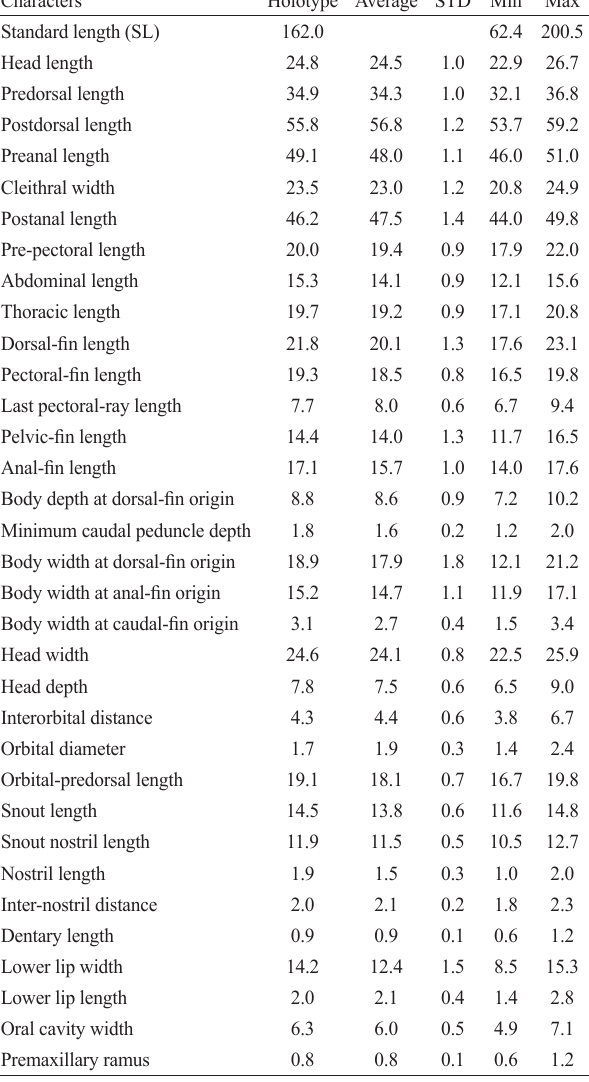
Tab. 1. Morphometric data of Pseudohemiodon unillano